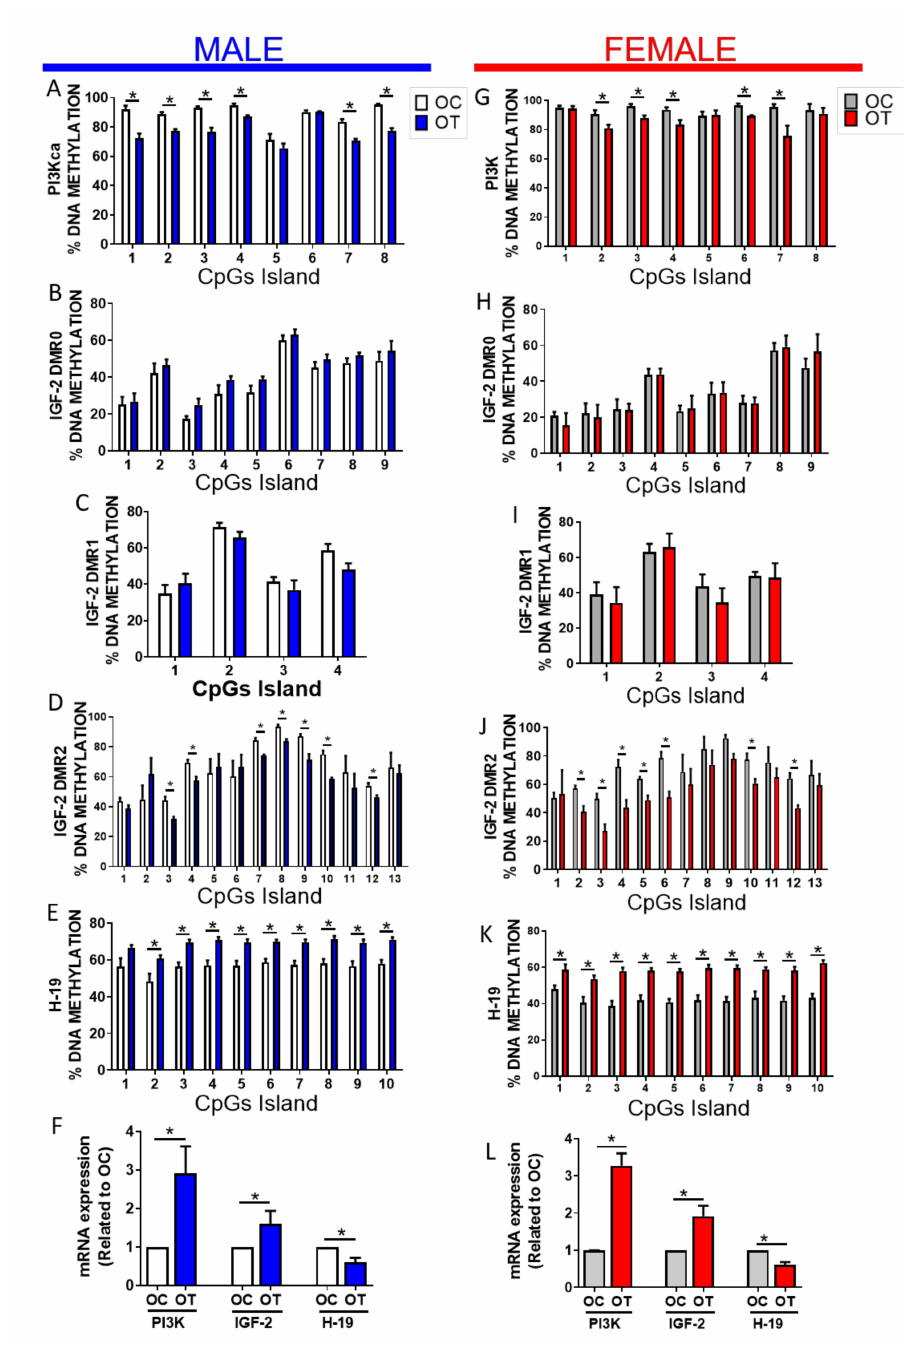
Figure 4. DNA methylation and gene expression analysis in the skeletal muscle offspring from seden- tary or exercise-trained progenitors. ( A – E ) DNA methylation percentage at the ( A ) PI3Kca intragenic region of (Coordinates: chr3:32356060-32356676), ( B ) the Igf2 DMR-0; (Coordinates: chr7:149839803- 149839897), ( C ) the Igf2 DMR-1 (Coordinates: chr7:149840128-149840338), ( D ) the Igf2 DMR-2; (Coor- dinates: chr7:149850877-149856303) and ( E ) the H19 DMR (Coordinates: chr7: